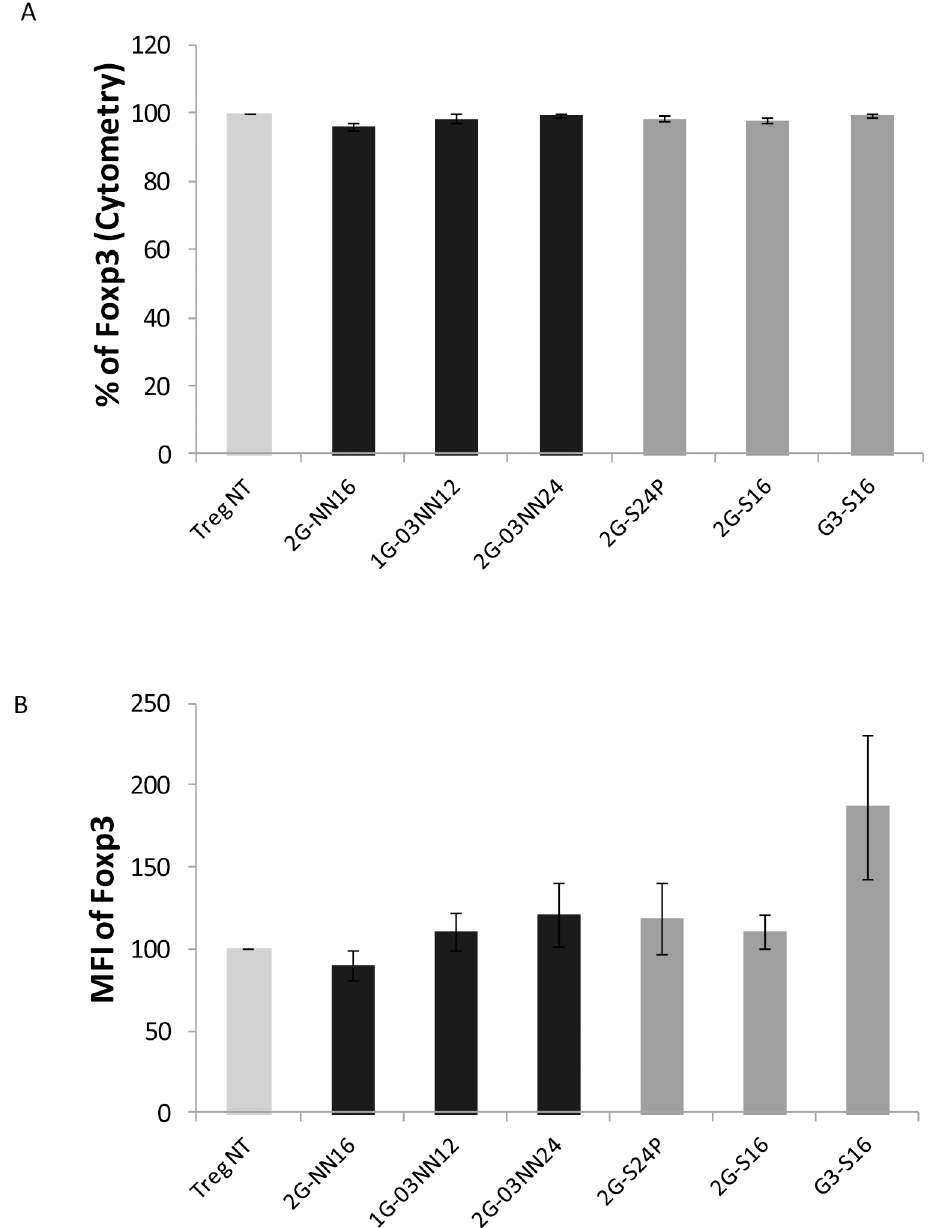
Fig 2. Foxp3 expression on Treg cells was not affected by dendrimers treatment. Percentage (A) and MFI (B) of Foxp3 expression was analyzed in treated Treg after 48 hours of treatment with cationic or anionic dendrimers. Values of Foxp3 expression were calculated and normalized regarding the non-treated Treg (Treg NT) condition that was considered as 100% of expression. Mean + SEM of 2G-NN16 (n = 8), 1G- 03NN12 (n = 5), 2G-03NN24 (n = 7), 2G-S24P (n = 7), 2G-S16 (n = 5), and G3-S16 (n = 4) independent experiments are shown. The analyses were performed with the Wilcoxon paired